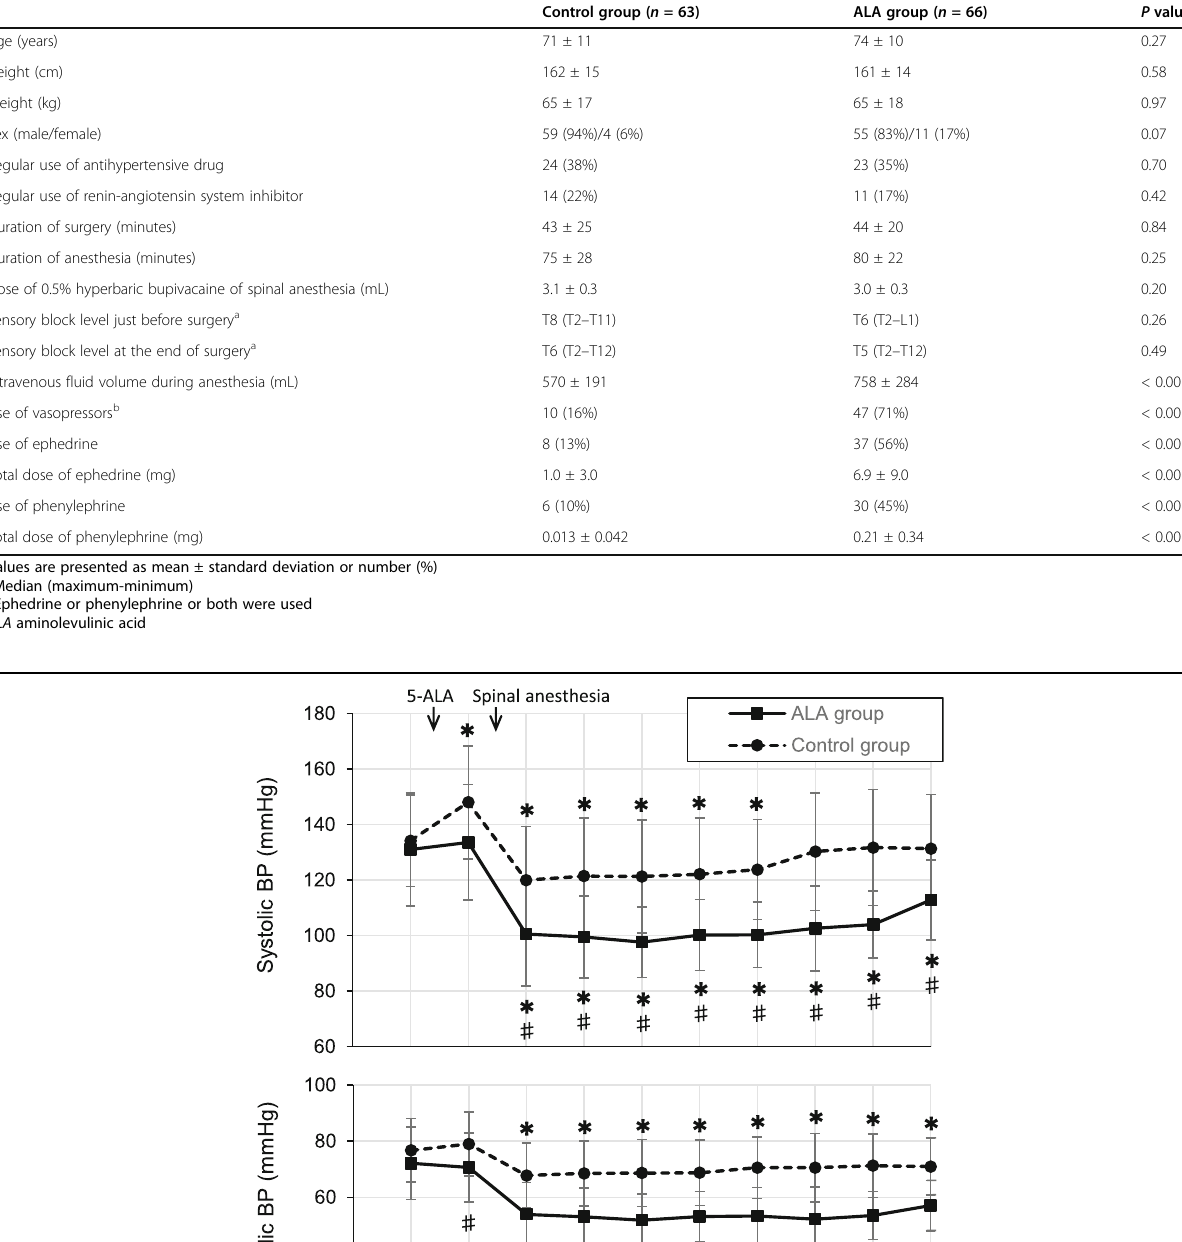
Table 1 The patients ’ preoperative characteristics, anesthesia profiles and the drugs administered during